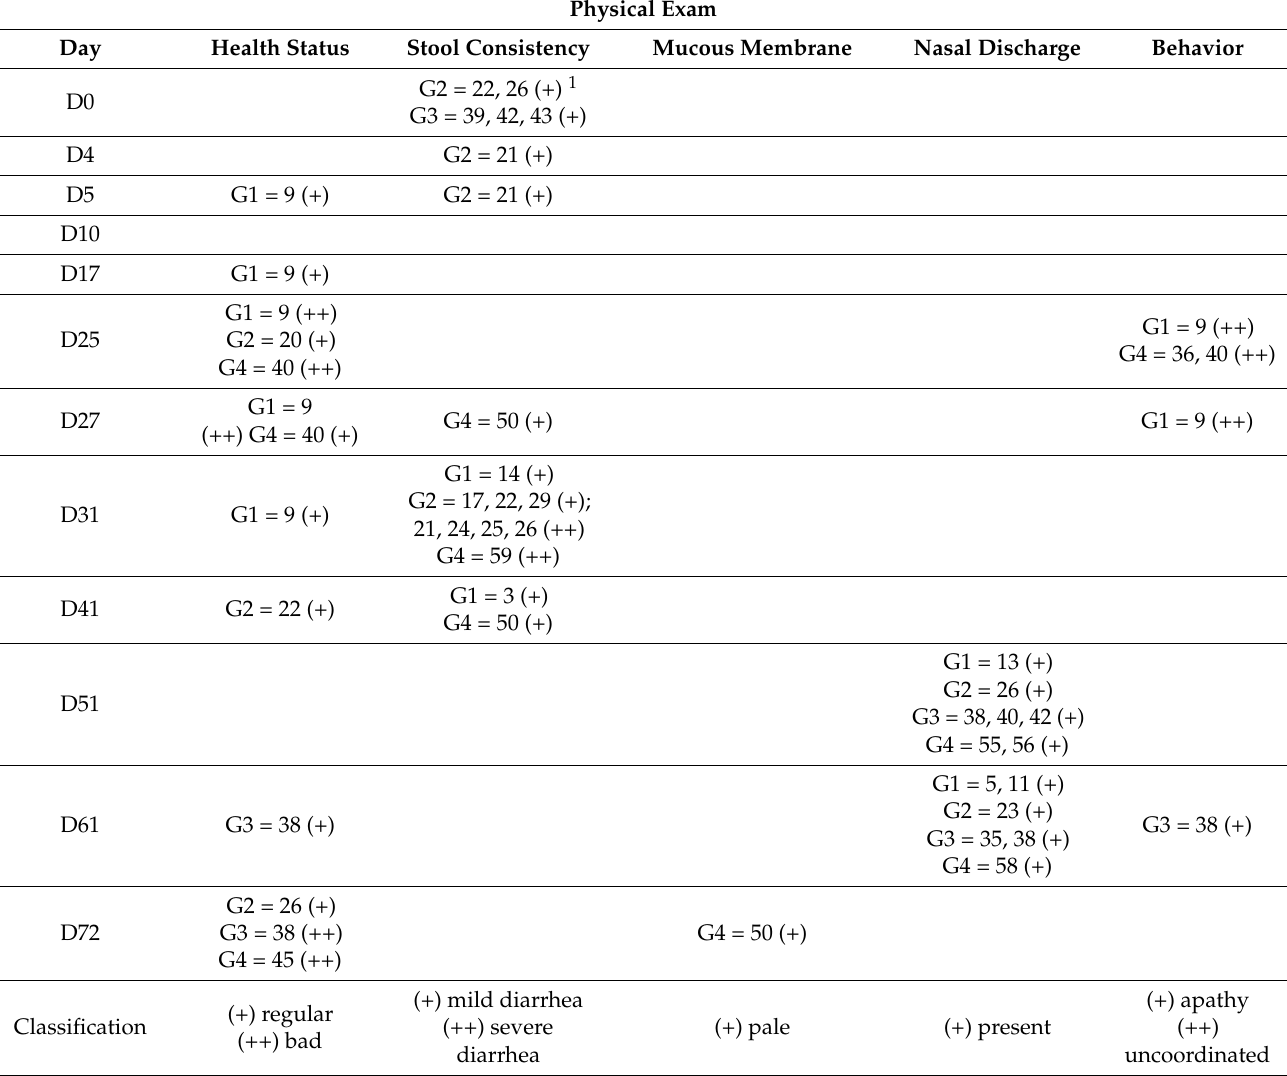
Table 1. Physical parameters evaluated in animals from groups 1 to 4 throughout the study period with individual identification, group identification, and degree of